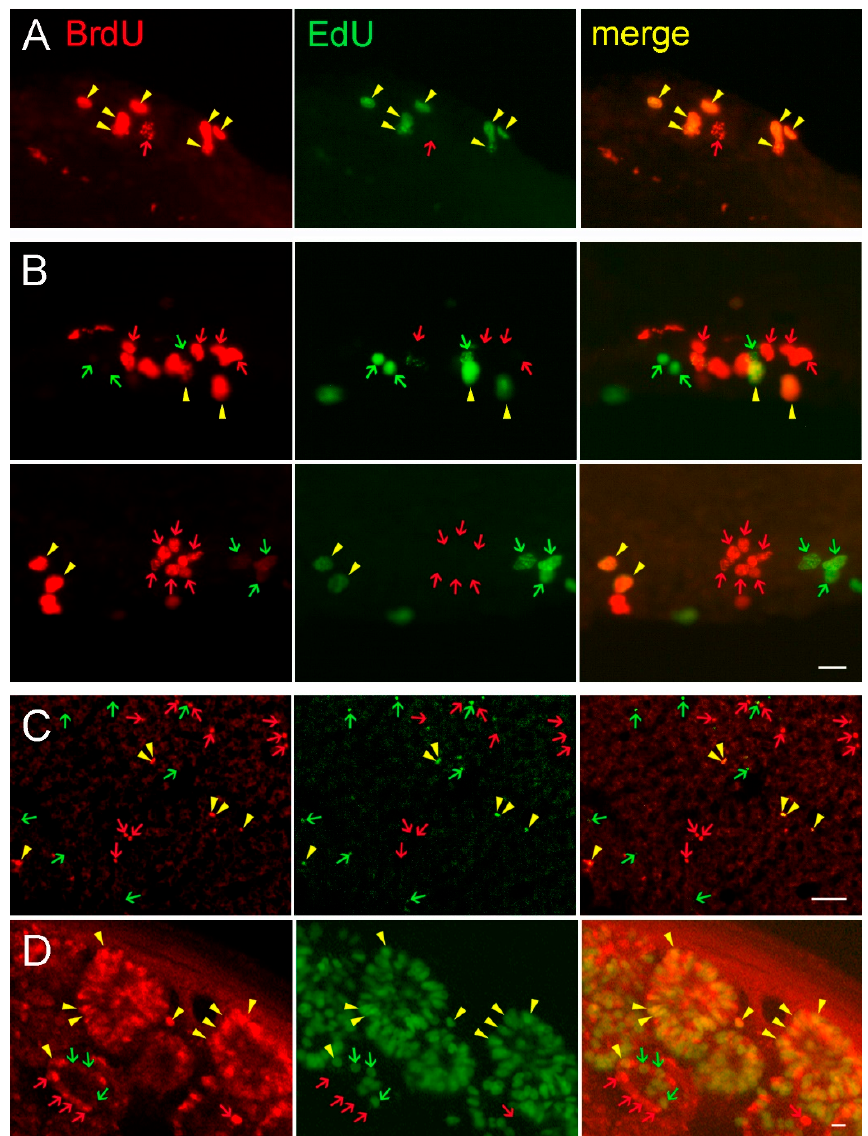
Figure 6. Fluorescent immunohistochemical labeling of BrdU (red) and fluorescent detection of EdU (green) in the brain ( A , B ), liver ( C ), and intestine ( D ) after injection of the proliferation markers in the same animal. ( A ) BrdU + and EdU + cells in VZ when the markers were injected simultaneously. ( B ) BrdU + and EdU + cells in VZ when the markers were injected with 6 h delay. Upper row—BrdU injection followed by EdU, lower row—EdU injection followed by BrdU. BrdU + and EdU + cells in liver ( C ) Liver and intestine ( D ) when the markers were injected with 6 h delay (BrdU first). BrdU was detected by the antibody MoBU-1. Red and green arrows point to the single labelled cells, yellow arrowheads point to the double labelled cells. The images document the results shown in Figure 5. The white scale bar represents 10 μ m in A and D and 50 μ m in C .